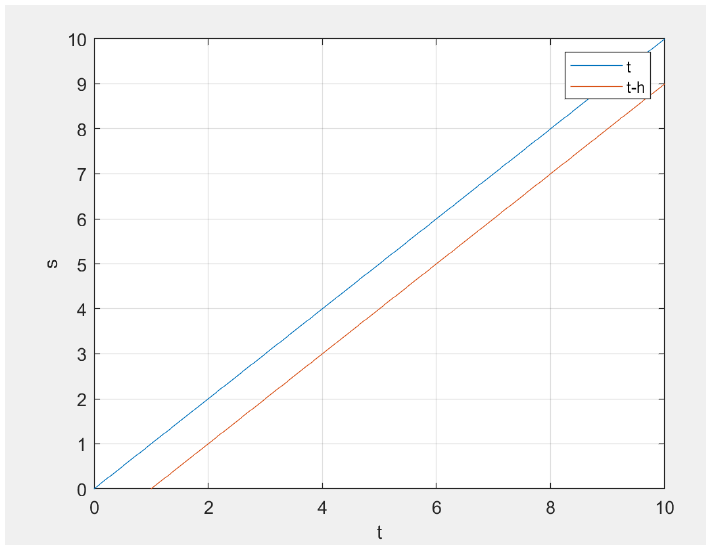
Figure 1. To description of kernels in the integral